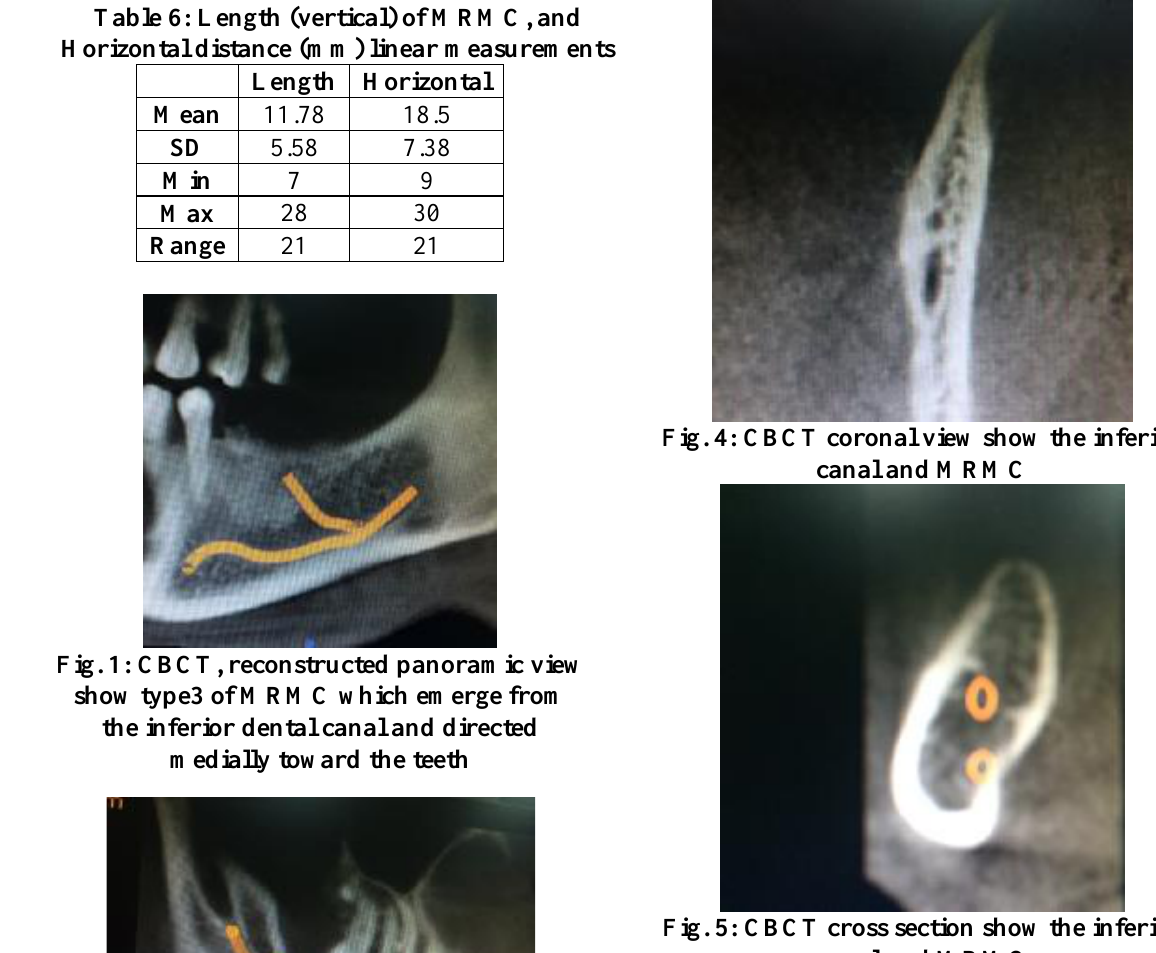
Fig. 5: CBCT cross section show the inferior canal and